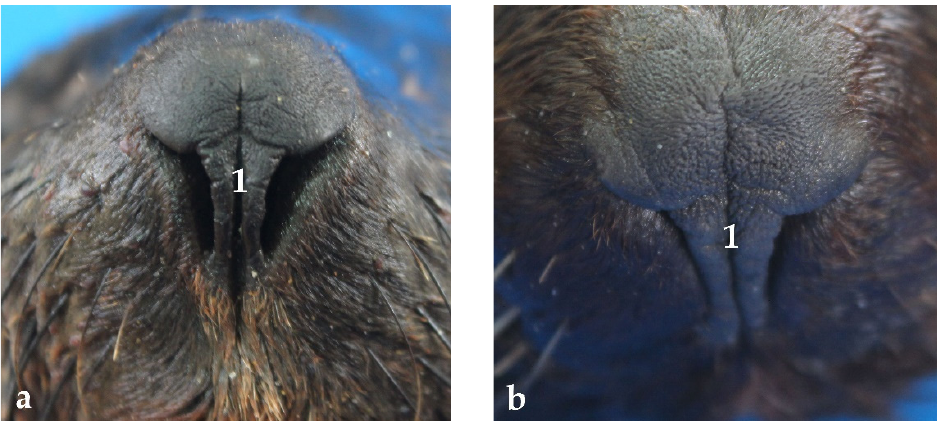
Figure 1. Frontal view of the nares: opened ( a ) and slightly closed ( b ). Note the presence of different furrows, (1) middle furrow or